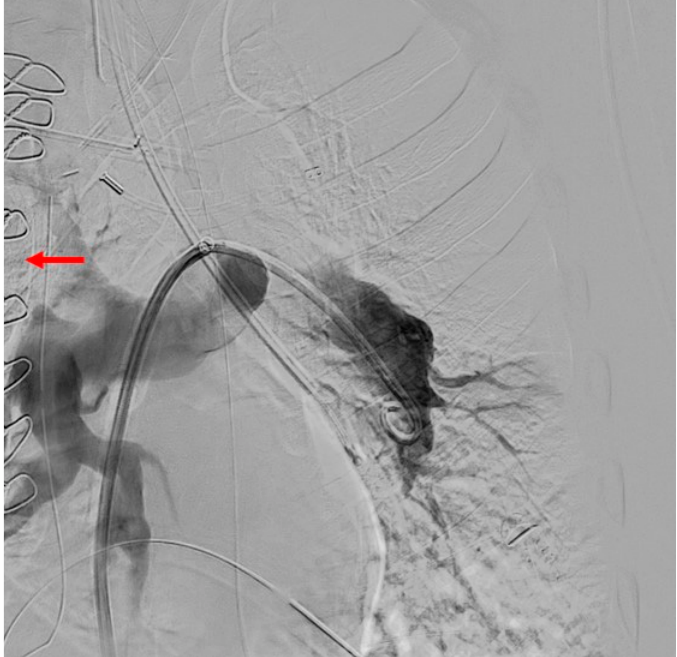
Figure 8. Postoperative endarterectomy specimen from both sides ( right and left ).